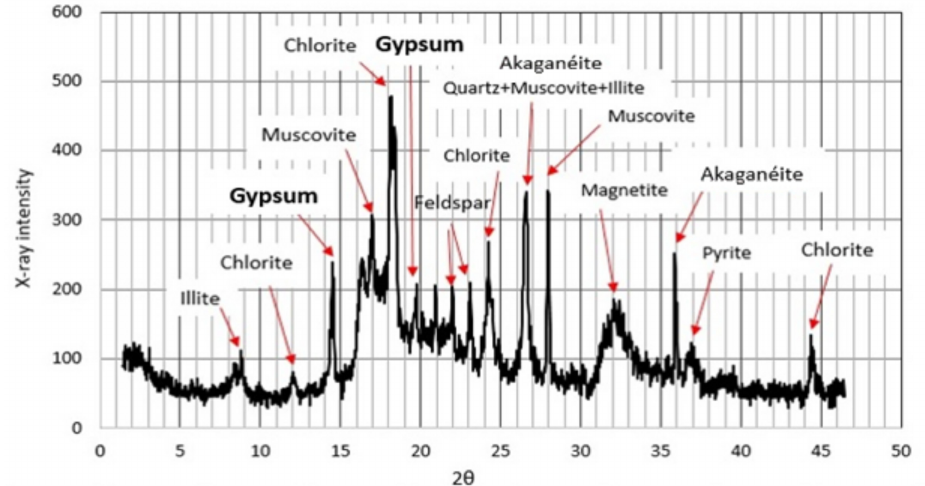
Figure 6. Mineralogy of the bottom sediment identified by X-ray diffraction. θ : Bragg angle ( ◦ ). The peaks of Akagan é ite exist as a mineralogical